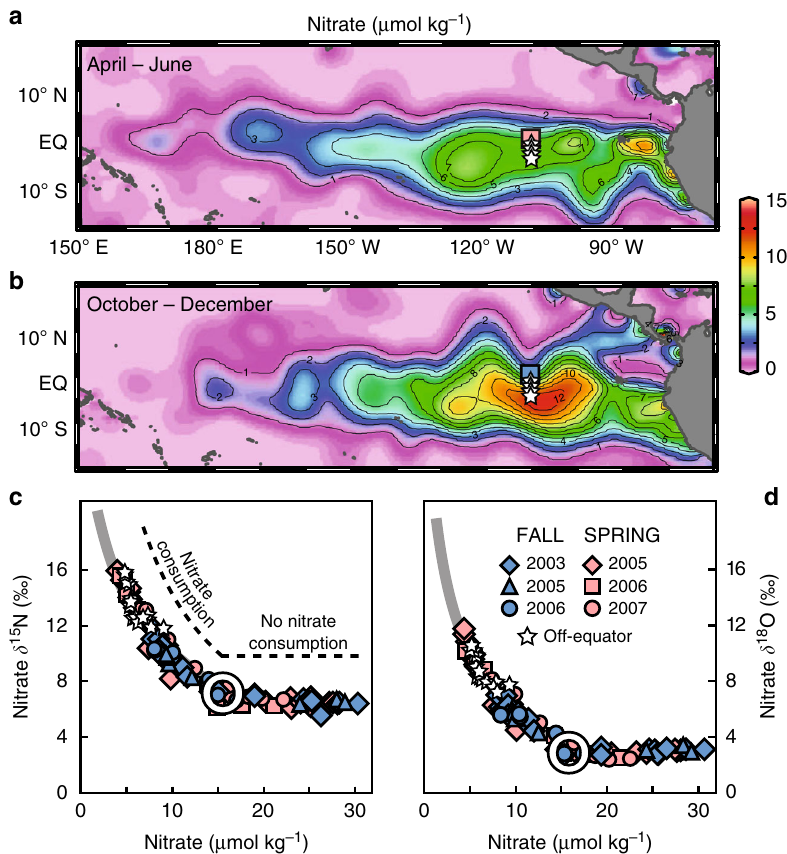
Fig. 1 Tropical Paci fi c nitrate concentration and isotopic composition. Tropical Paci fi c surface nitrate concentrations for a April – June and b October – December 70 , with squares and stars indicating station locations. c , d show nitrate δ 15 N and δ 18 O measurements vs. nitrate concentration for the samples from these stations. Pink and blue symbols are ± 1° of equator during boreal spring and fall, respectively. White stars indicate 2 – 4° S surface mixed layer measurements. Plotted data are from the upper 200 m of the water column. White circles in c , d indicate the averages of measurements of the Equatorial Under Current (EUC) at 110° W 18 , and these values are used to drive the Rayleigh (closed system) model of nitrate assimilation (gray lines) 18 (see text for more